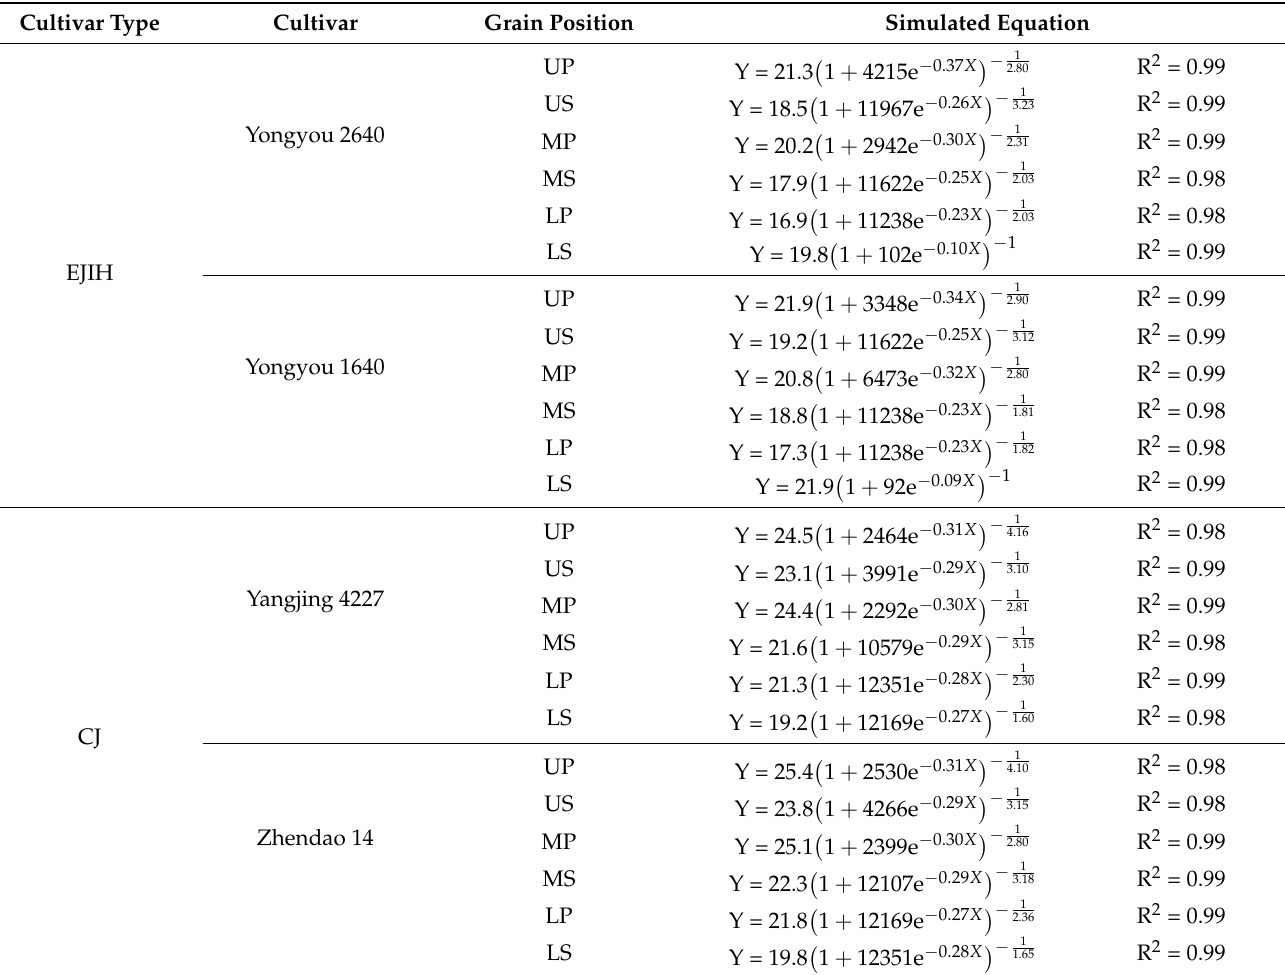
Table 8. Simulated equations of the grain-filling dynamics of rice